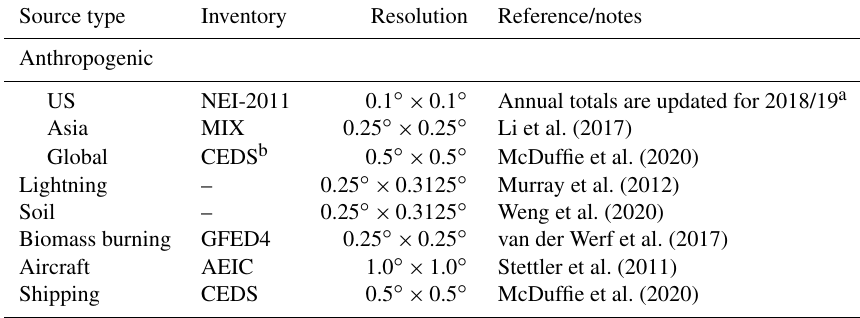
Table 2. Emissions inventories in GEOS-Chem 13.0.0 that represent NO x sources in the simulations conducted in this paper.